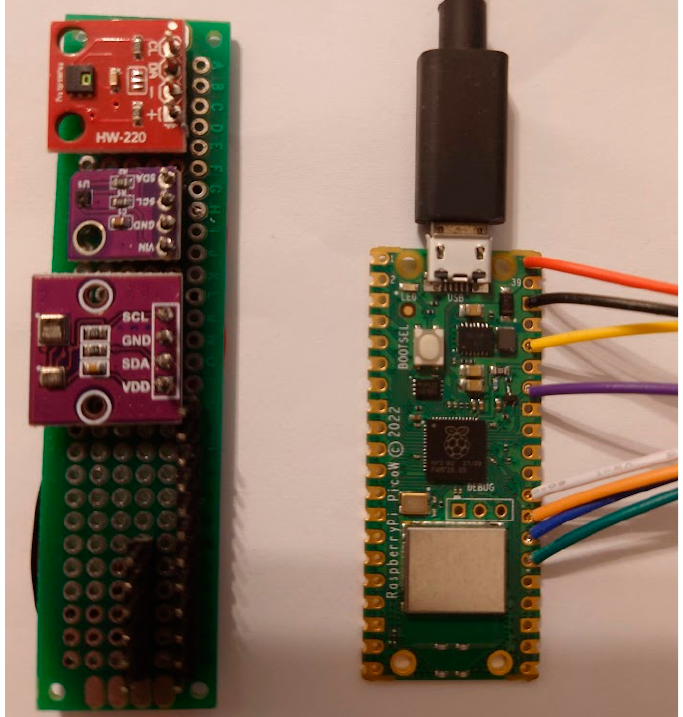
Figure 2. Example of sensor connection with a Raspberry Pi Pico W.